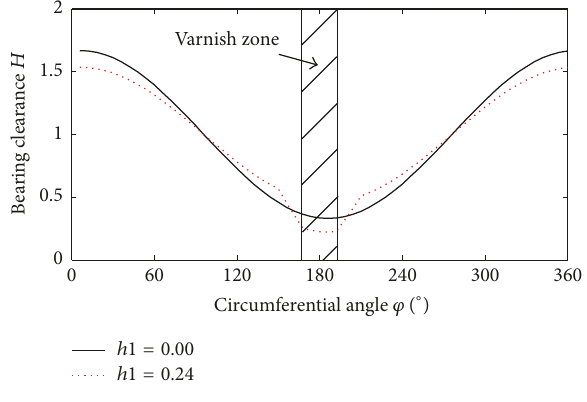
Figure 5: Oil film thickness distribution.